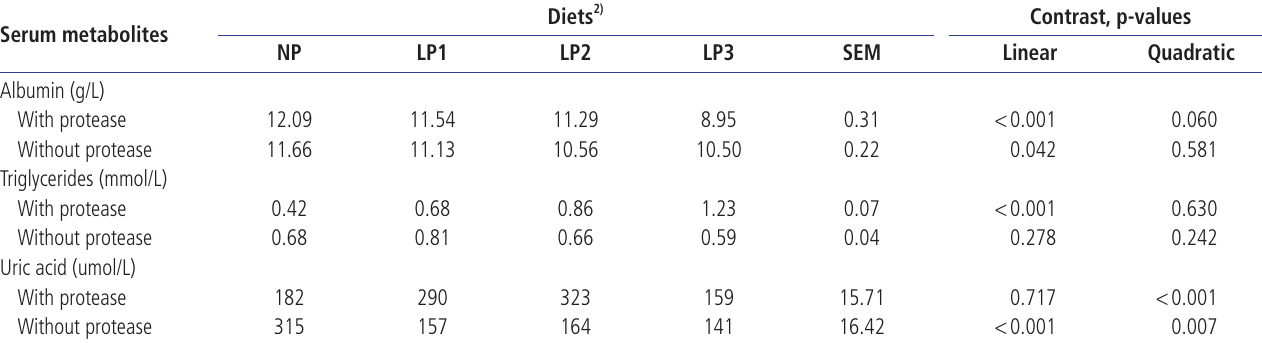
Table 4. Albumin, triglycerides, and uric acid in broiler chickens at 35 days of age when interactions between crude protein level and protease enzyme supplementation were significant 1)